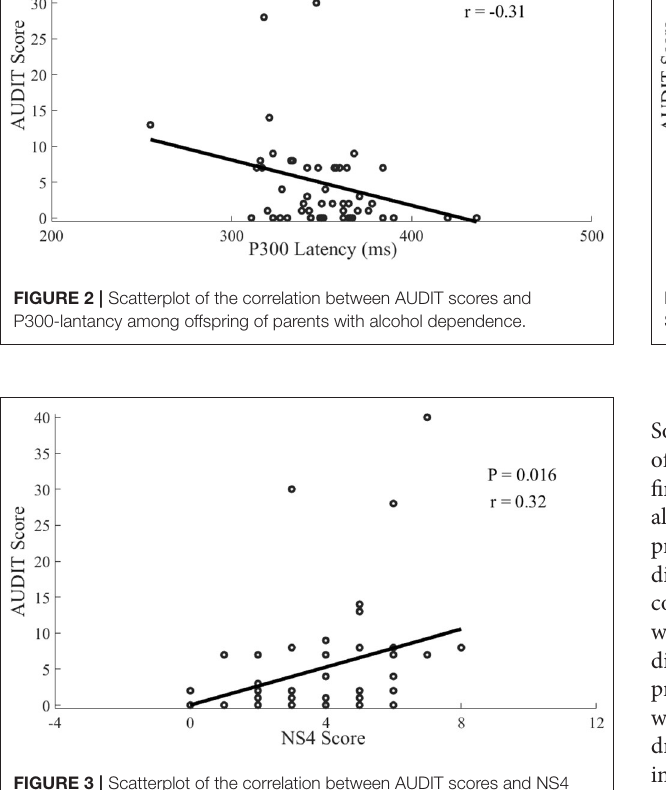
FIGURE 3 | Scatterplot of the correlation between AUDIT scores and NS4 Score among offspring of parents with alcohol dependence.